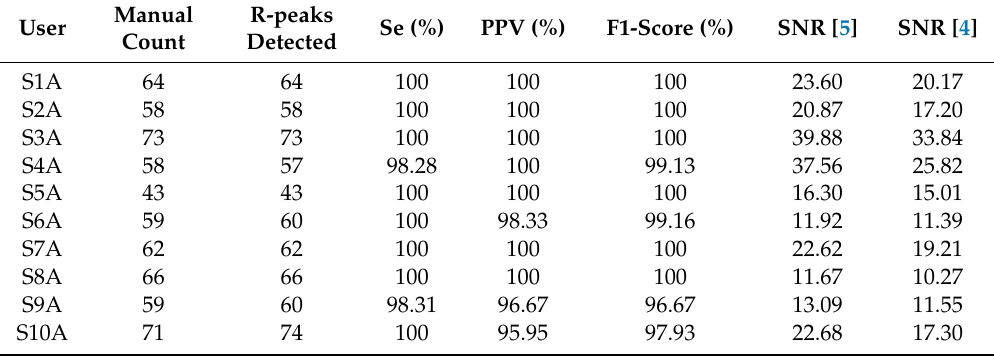
Figure 21. Photos of the devised arm-ECG sensor prototype (WAMECG1) being worn by volunteers. Table 9. R-peak detection and SNR calculations for users resting.